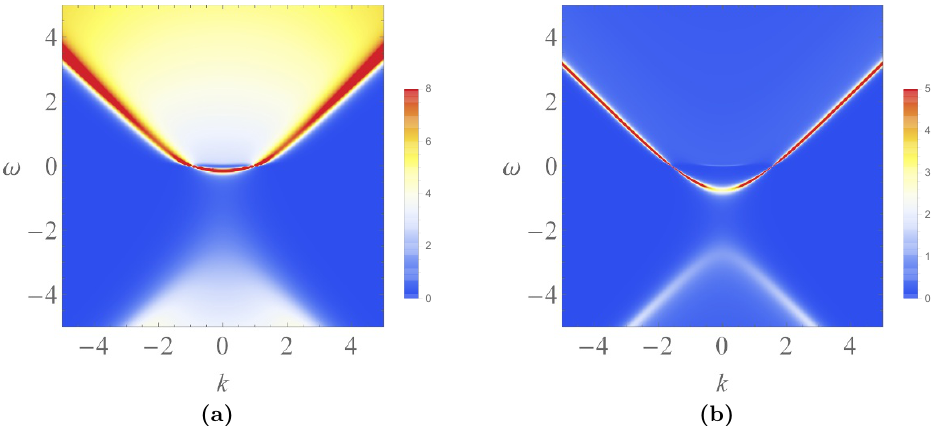
Figure 9 . The holographic spectral function for (cid:22) = 2 and (cid:21) = 1 in (a) standard and (b) alternative quantization. The Fermi surface is most clearly visible in alternative quantization, where k F = 1 :